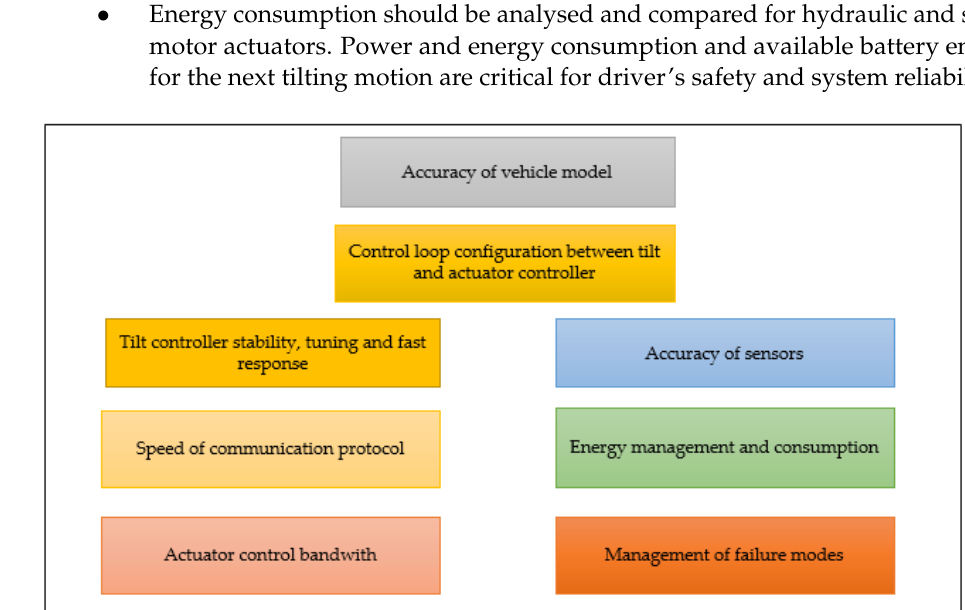
Figure 1. Critical design parameters effecting on tilt control performance.